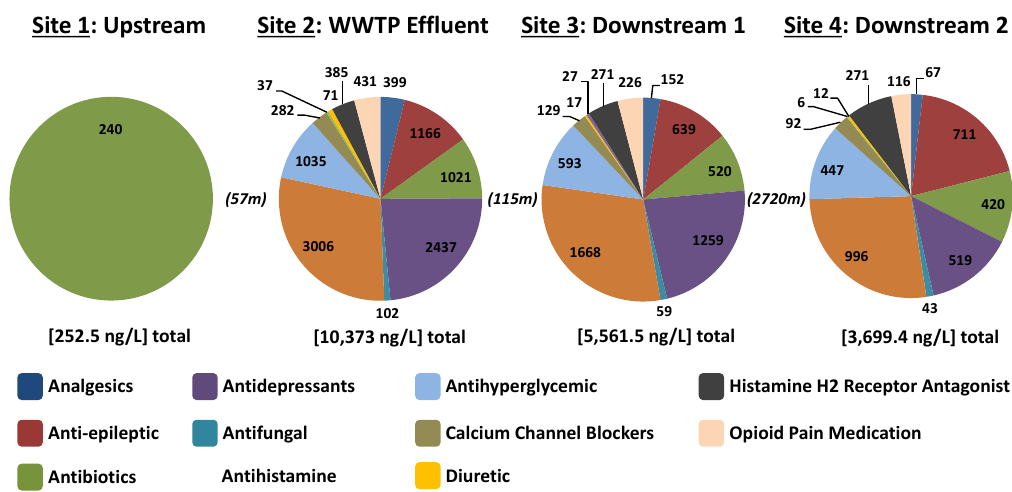
Figure 5. Muddy Creek study sites by proportion of detected therapeutic class of the 61 target APIs in the presented method with [site total concentration] and ( distance between sites in meters ). Pie charts are labelled with the total detected concentration (ng/L) of APIs belonging to respective therapeutic classes.